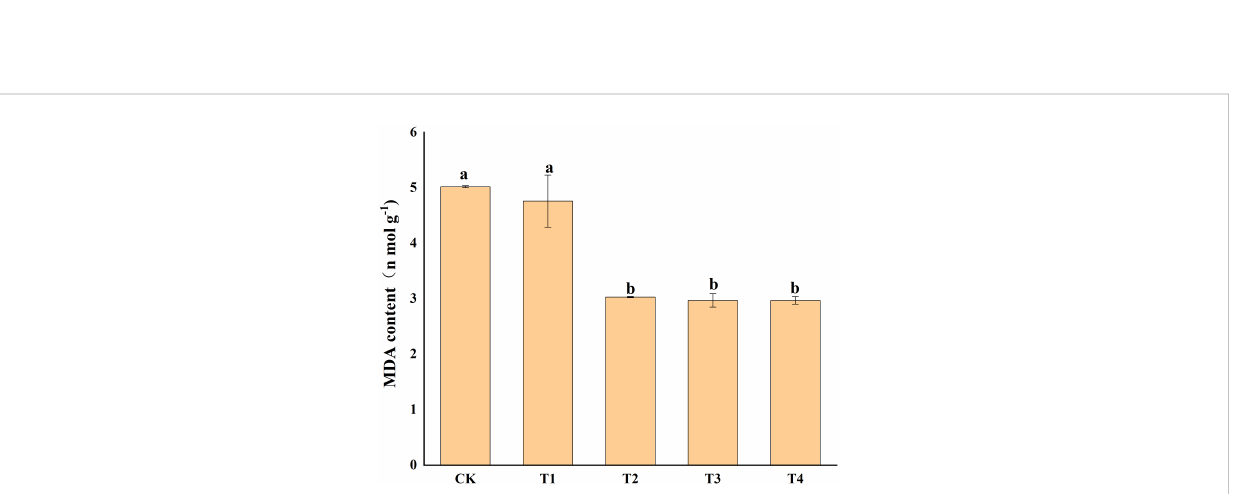
FIGURE 5 Effects of different Si treatments on MDA content of S. alfredii . CK: control treatment, T1, T2, T3 and T4 were the Si concentrations of 0.5, 1.0, 1.5 and 2.0 mmol ∙ L -1 , respectively. Values are mean ± SD and columns denoted with different letters indicate signi fi cant differences between treatments at P <